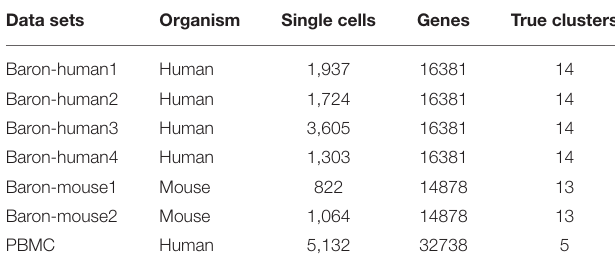
TABLE 1 | The statistics of seven benchmark data